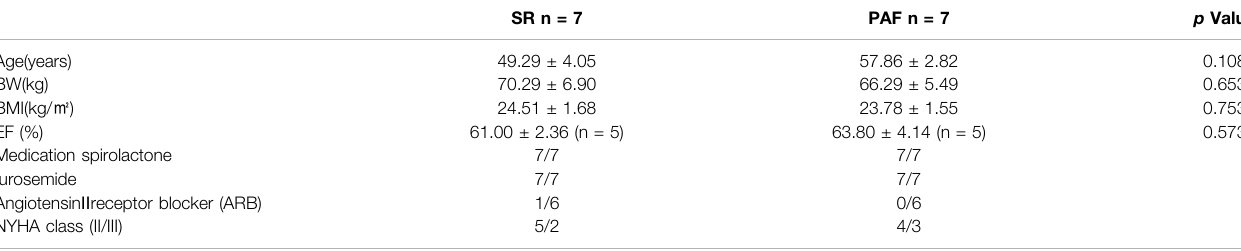
TABLE 1 | The clinical subject characteristics (mean ±